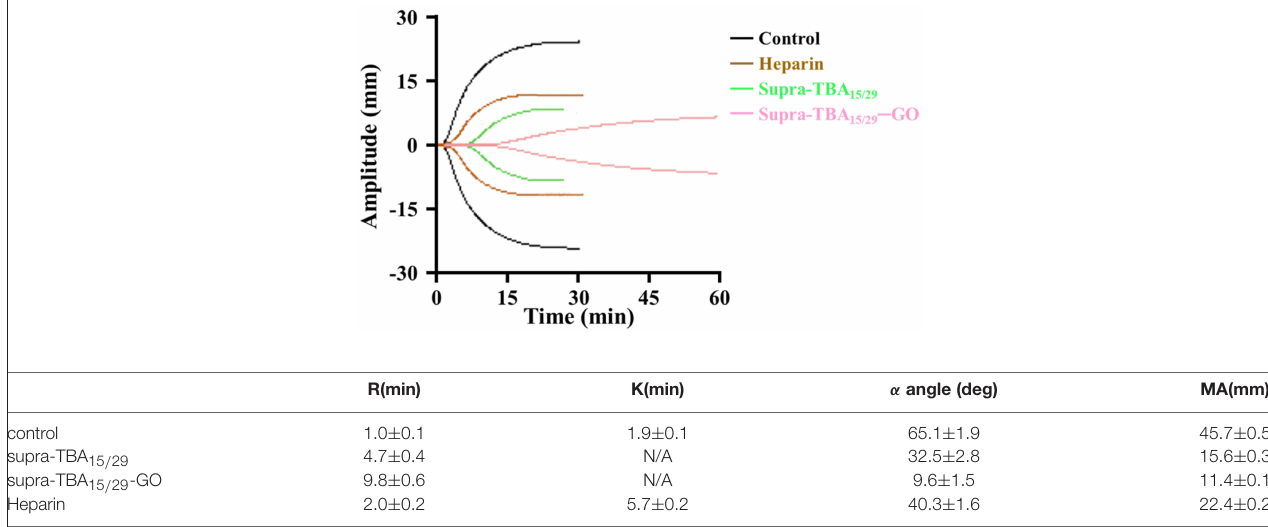
of 480–500 nm when it binds to nucleic acids in dead